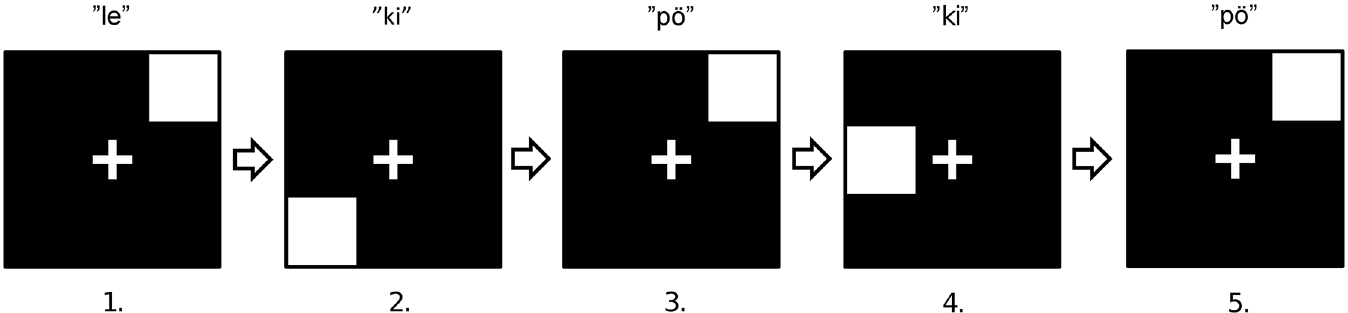
Fig 4. Example of a short dual 2-back sequence. The aurally presented syllables are written above the matrix in this example. The left response button (location match) should be pressed on the third and fifth trials, while the right response button (syllable match) should be pressed on the fourth and fifth trials.